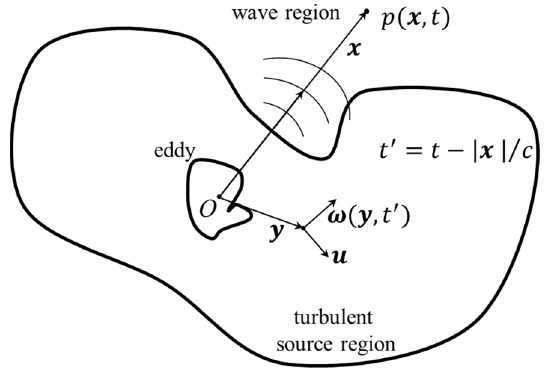
Figure 2. Sketch map of the vortex sound theory.